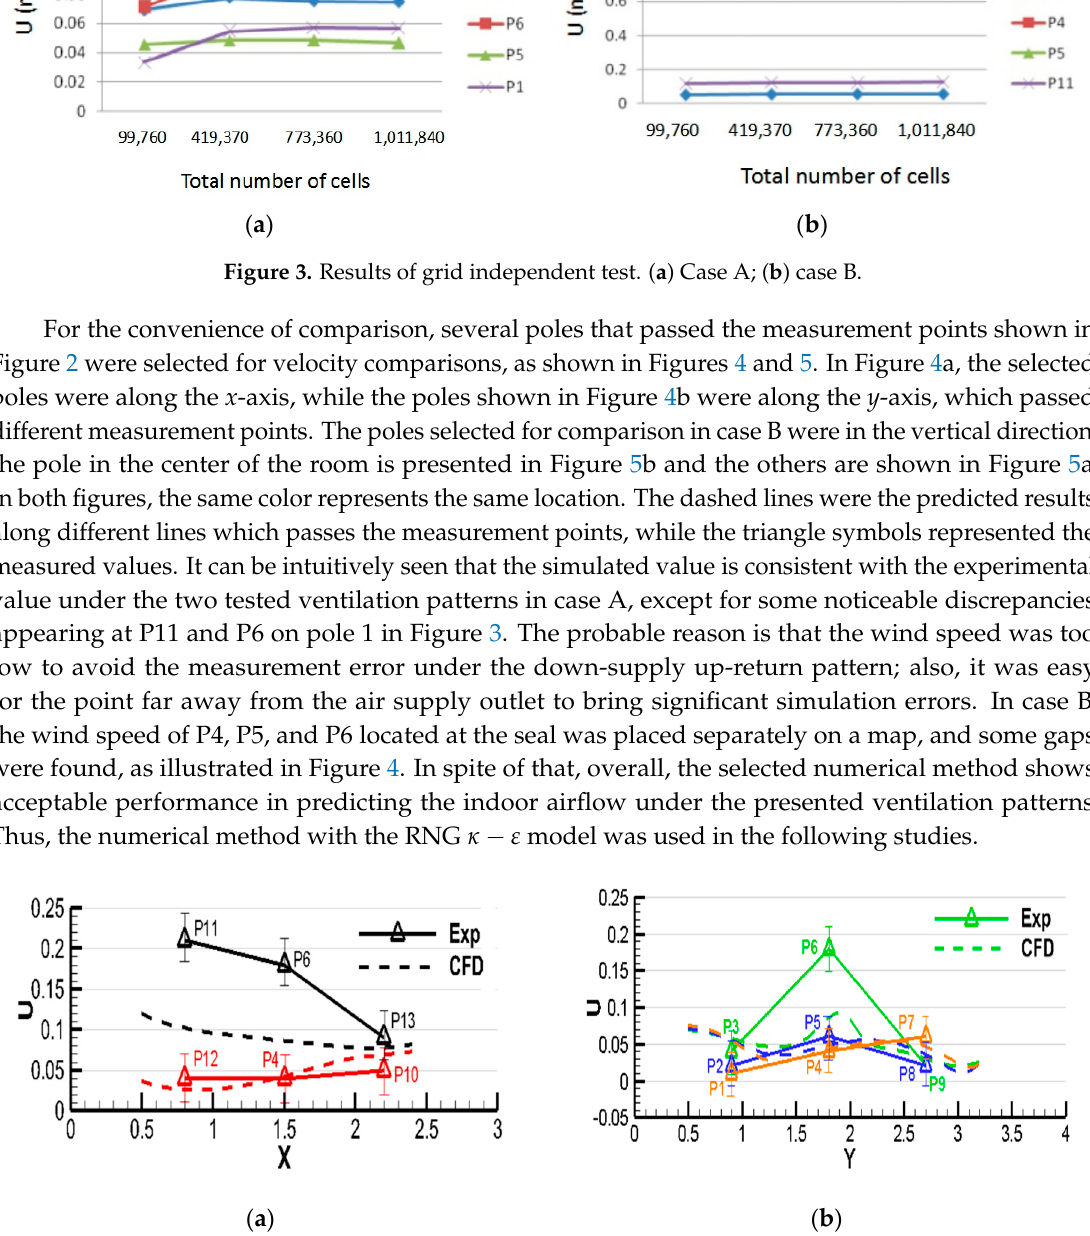
Figure 4. Comparison between experimental measurements and computational results for case A (( a ): along the x-axis, ( b ): along the y-axis. The same color represents the same location, Exp: Experiment, CFD: computational fluid dynamics).